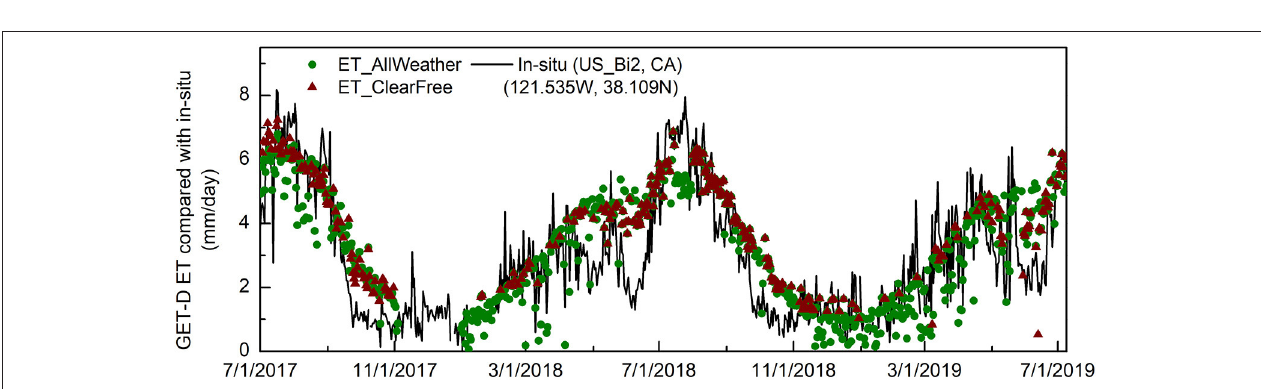
FIGURE 8 | Time series comparison between clear-sky ET and all-weather ET, as well as in-situ ET observations at the AmeriFlux station in North Carolina; (A) over the period from July 1, 2017 to Dec. 31, 2018; (B) Jan.1 – June 10, 2018; (C) Oct. 22 - Dec. 14, 2018.